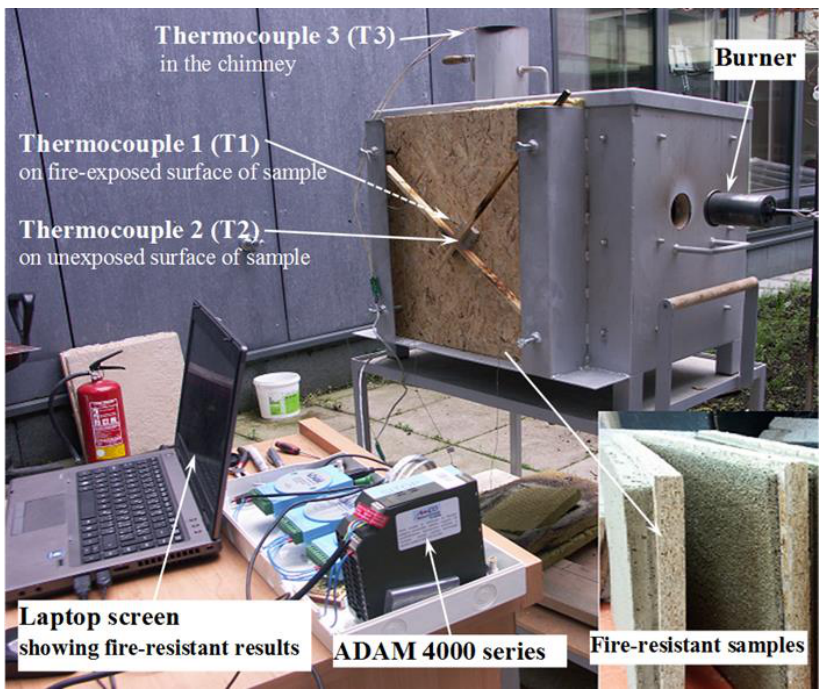
Figure 3. An image illustrating equipment for fire resistance test.